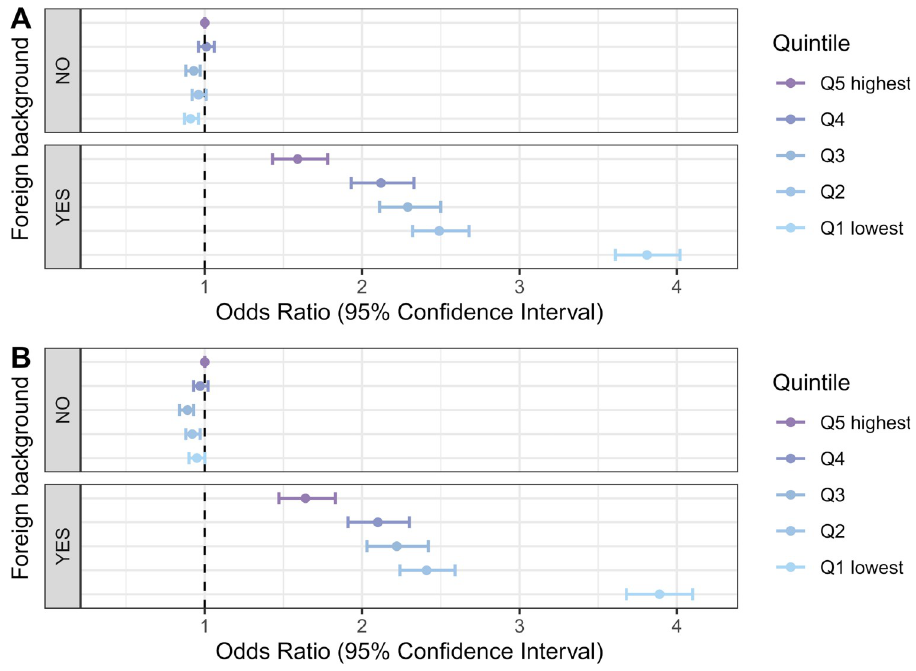
Fig 4. Odds ratios of COVID-19 incidence by household income quintile and foreign background status. In under-65 households (A) adjusted for age and age squared, sex, and regional characteristics; (B) adjusted for age and age squared, sex, regional characteristics, household size, and household-level work and school